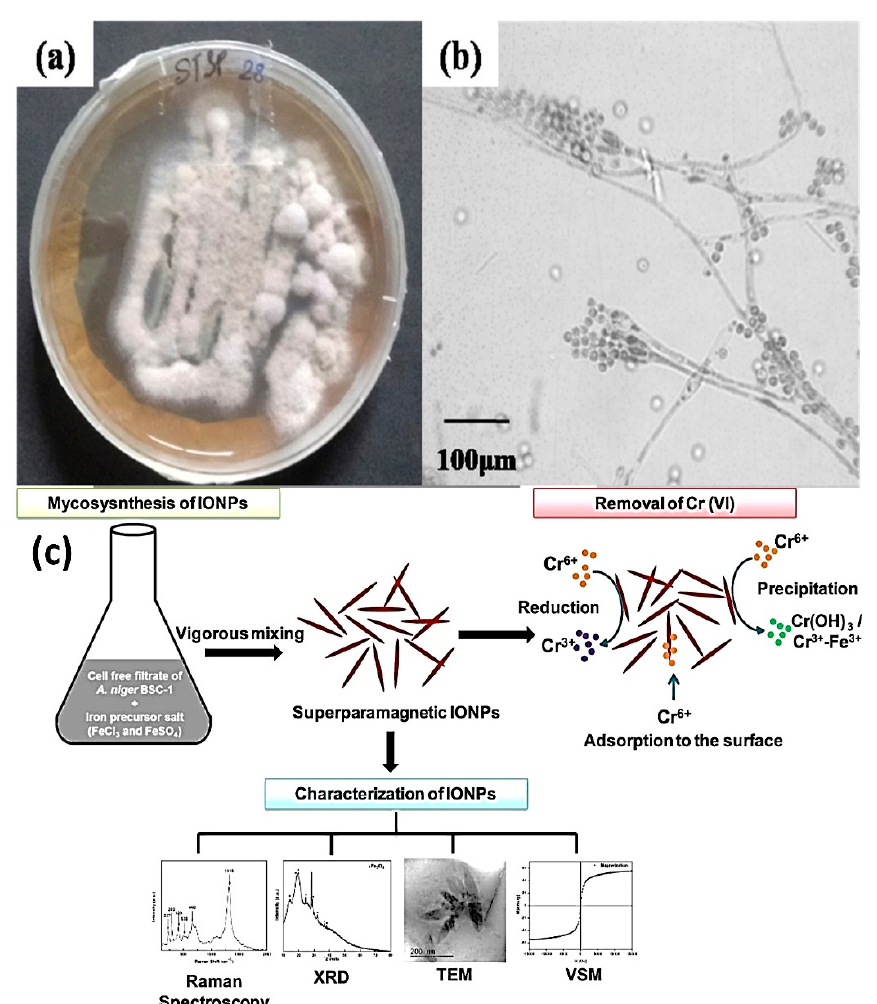
Figure 4. ( a ) This represents Manglicolous Fungal colony ( b ) Manglicolous fungi’s Compound microscopic image [60] ( c ) Desorption and reusability study, like efficiency of different regenerative solution for desorption of Cr, regeneration study. Reprinted/adapted with permission from Ref. [60]. 2022, Elsevier B.V”.